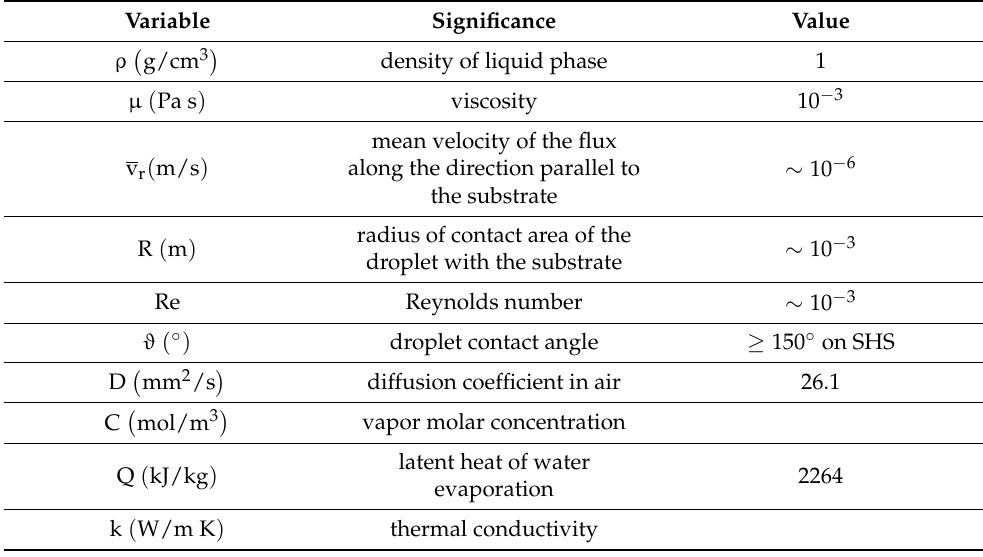
Table 2. Variables, units, and values used in numerical